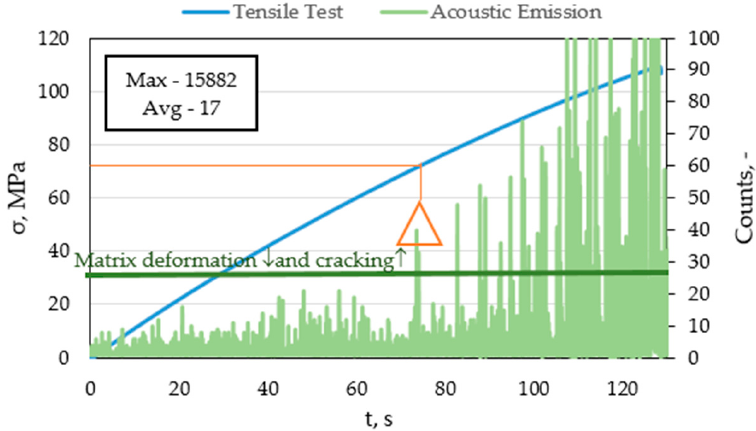
Figure 12. Graph of the counts plotted on tensile versus time plots for a selected FRP sample.